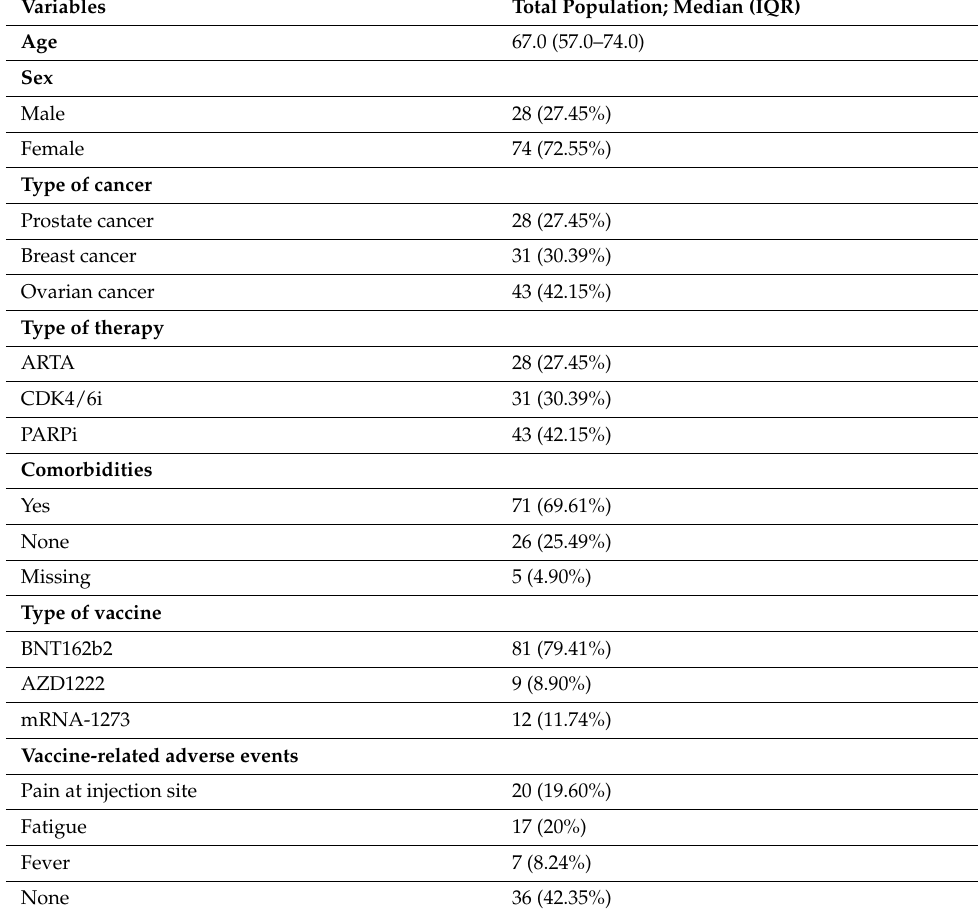
Table 1. Baseline characteristics of the